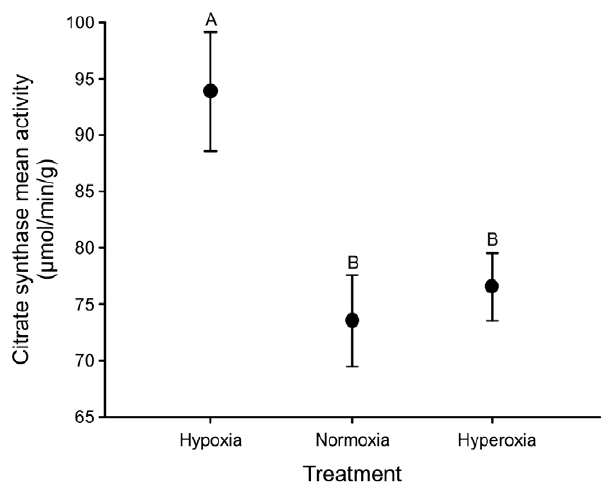
Figure 7. Variation among treatments in mitochondrial citrate synthase activity as measured in males at generation 29(24 hyperoxia). D. melanogaster populations evolved under normoxic, hypoxic, or hyperoxic conditions and were then raised in a common normoxic environment for two generations prior to conducting the assay. Treatment means 6 SEM of replicate populations are shown for clarity. The treatment effect was significant overall (p=0.002) and those not sharing a letter are statistically different in a post-hoc